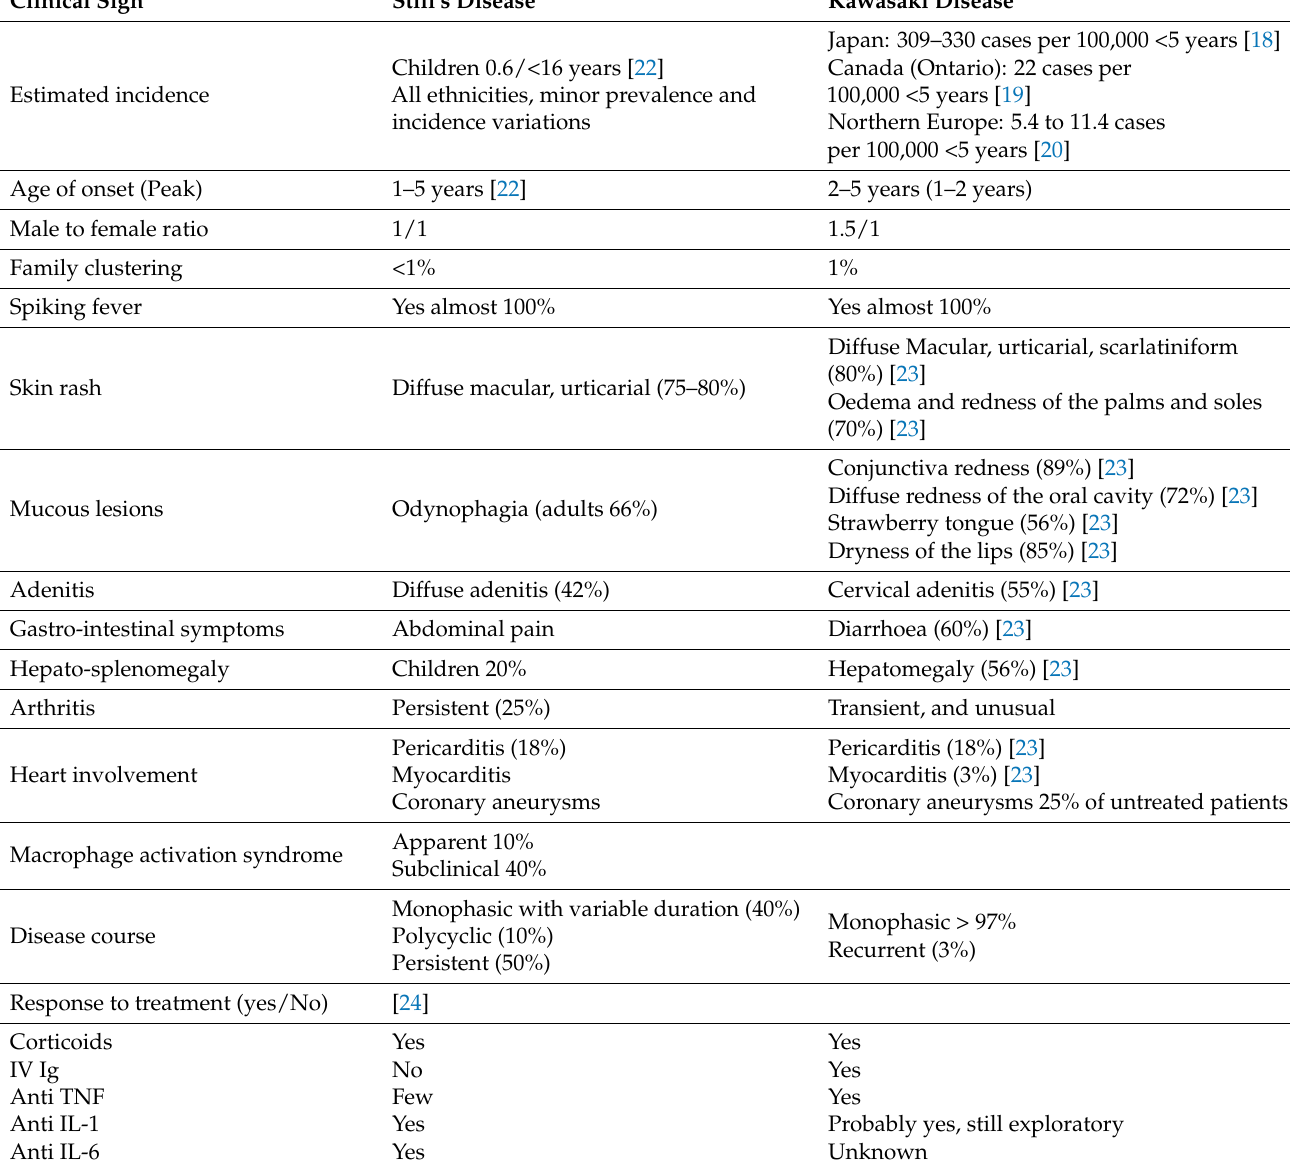
Table 1. Clinical characteristics of Kawasaki disease compared with systemic